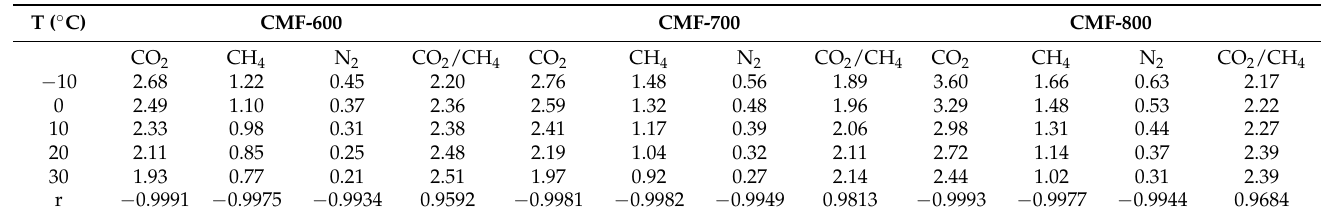
Table 3. CO 2 , CH 4 , and N 2 adsorbed (mmol/g adsorbent) at 1.0 bar in PANMF carbonized.